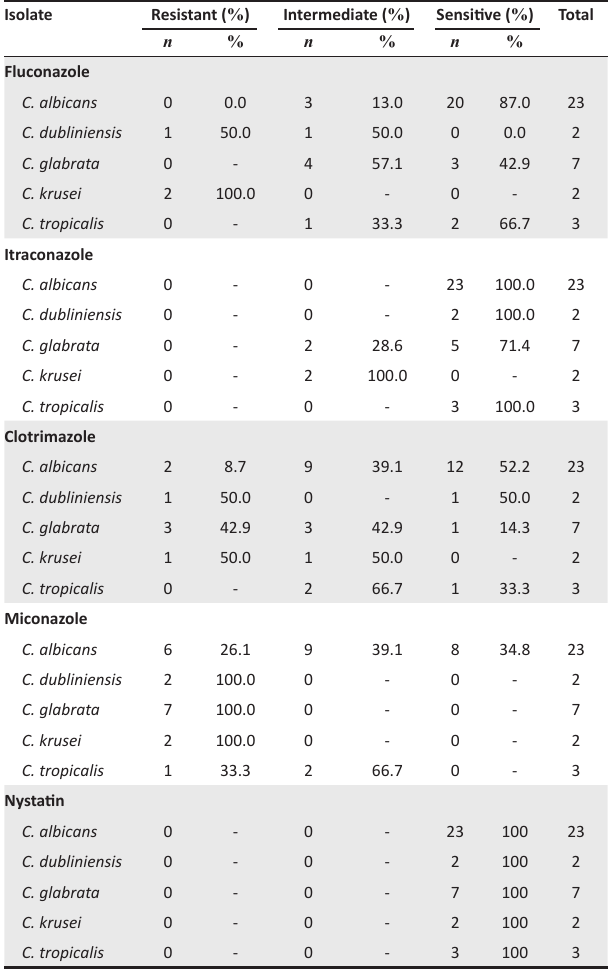
TABLE 2: Antifungal susceptibility profile of Candida isolates from diabetes mellitus patients ( n = 37 isolates), Kampala, Uganda, March 2017 to December